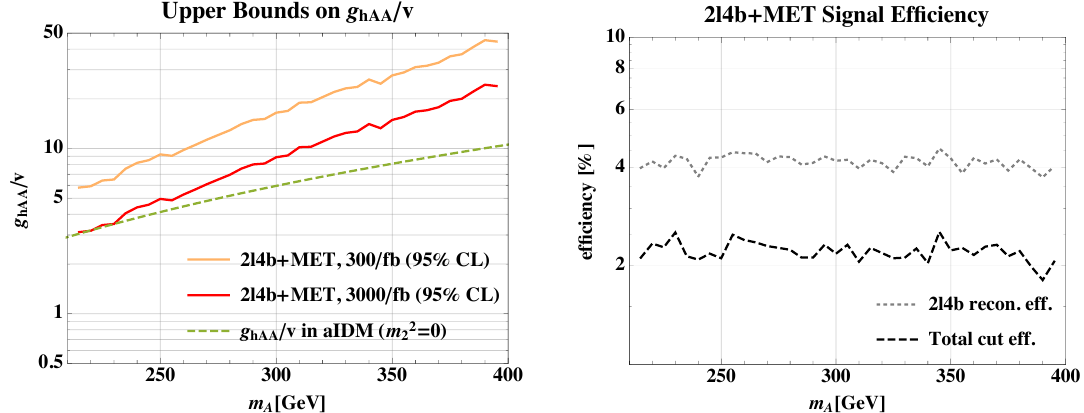
Figure 6. Left panel shows the upper limits on g hAA =v from pp ! h ! AA ! ( Zh )( Zh ) ! ( ‘‘bb )( (cid:23)(cid:23)bb ) at the LHC with 300 fb (cid:0) 1 and HL-LHC (3000 fb (cid:0) 1 ). We also include the value of g hAA =v in the aIDM for m 2 = 0, which is given by 4 m 2 =v 2 . Right panel shows the cut e(cid:14)ciency 2 A for the